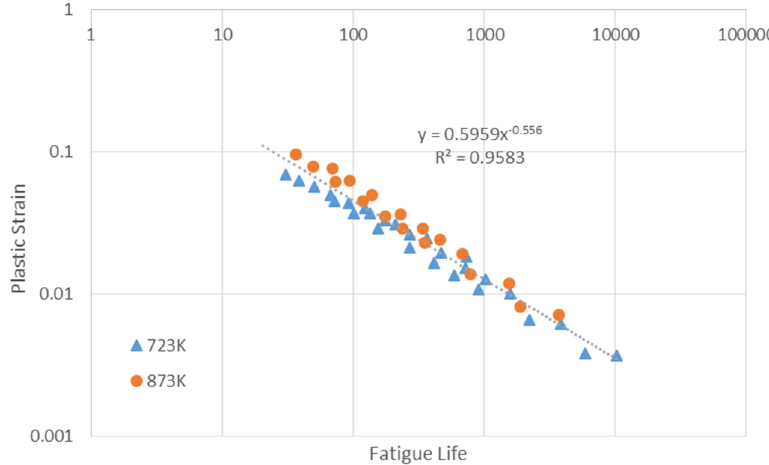
Figure 4. Transformed ε p, ref – N data (below 873 K) of stainless steel 316 using Equation (17) with functions c ( T , t ) and b ( T , t ).